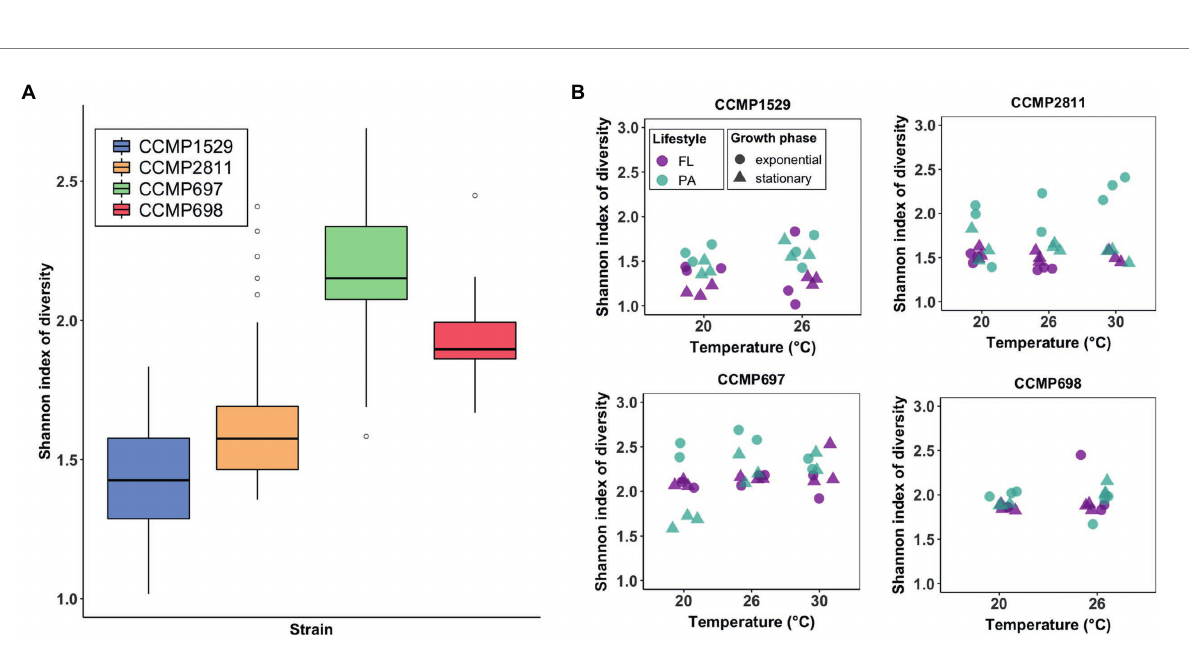
FIGURE 2 Analysis of Alpha diversity of the bacterial communities of Prorocentrum cordatum measured by mean Shannon diversity index. (A) Total Shannon diversity index of the bacterial communities. All samples were grouped by strain and are indicated by color. The solid black lines indicate medians, and the lower and upper bounds of the box represent the 25% and 75% quartiles. Outliers are indicated as open circles and represent samples falling outside the 10% and 90% quartiles. (B) The Shannon diversity between temperature (x-axis), lifestyles (color) and growth phase (shape) was analyzed for the bacterial communities of each P. cordatum